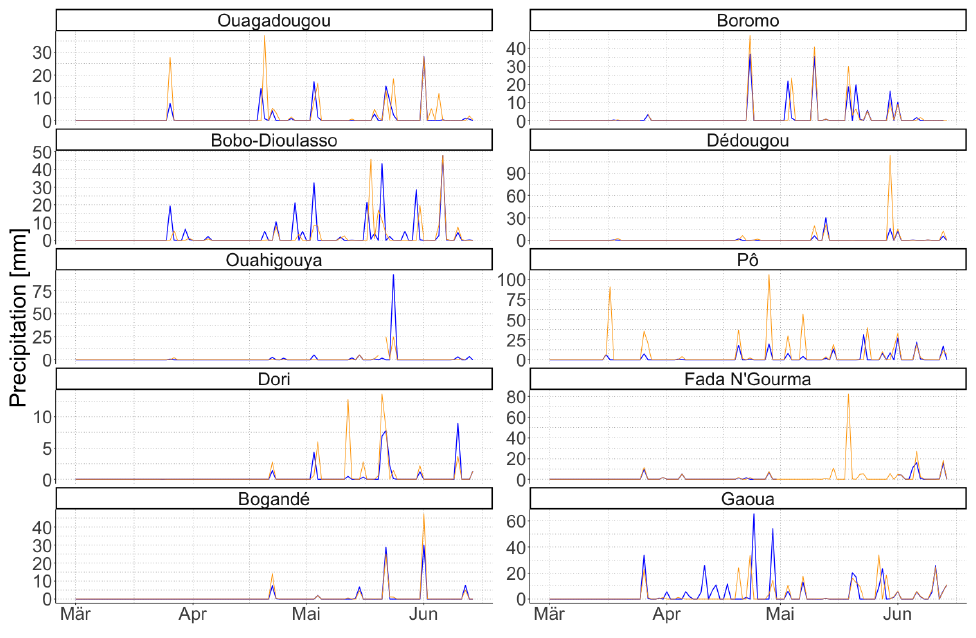
Figure 11. Comparison of precipitation time series between TAHMO stations in orange and the corre- sponding stations from meteorological service of Burkina Faso (BF) in blue from 2019-03-01–2019-06-15 to emphasize the different onsets of the monsoon in 2019. Stations in the southern part start earlier (Gaoua, Pô, Bobo-Dioulasso) compared to stations in northern BF (Ouahigouya, Bogandé, Dori).